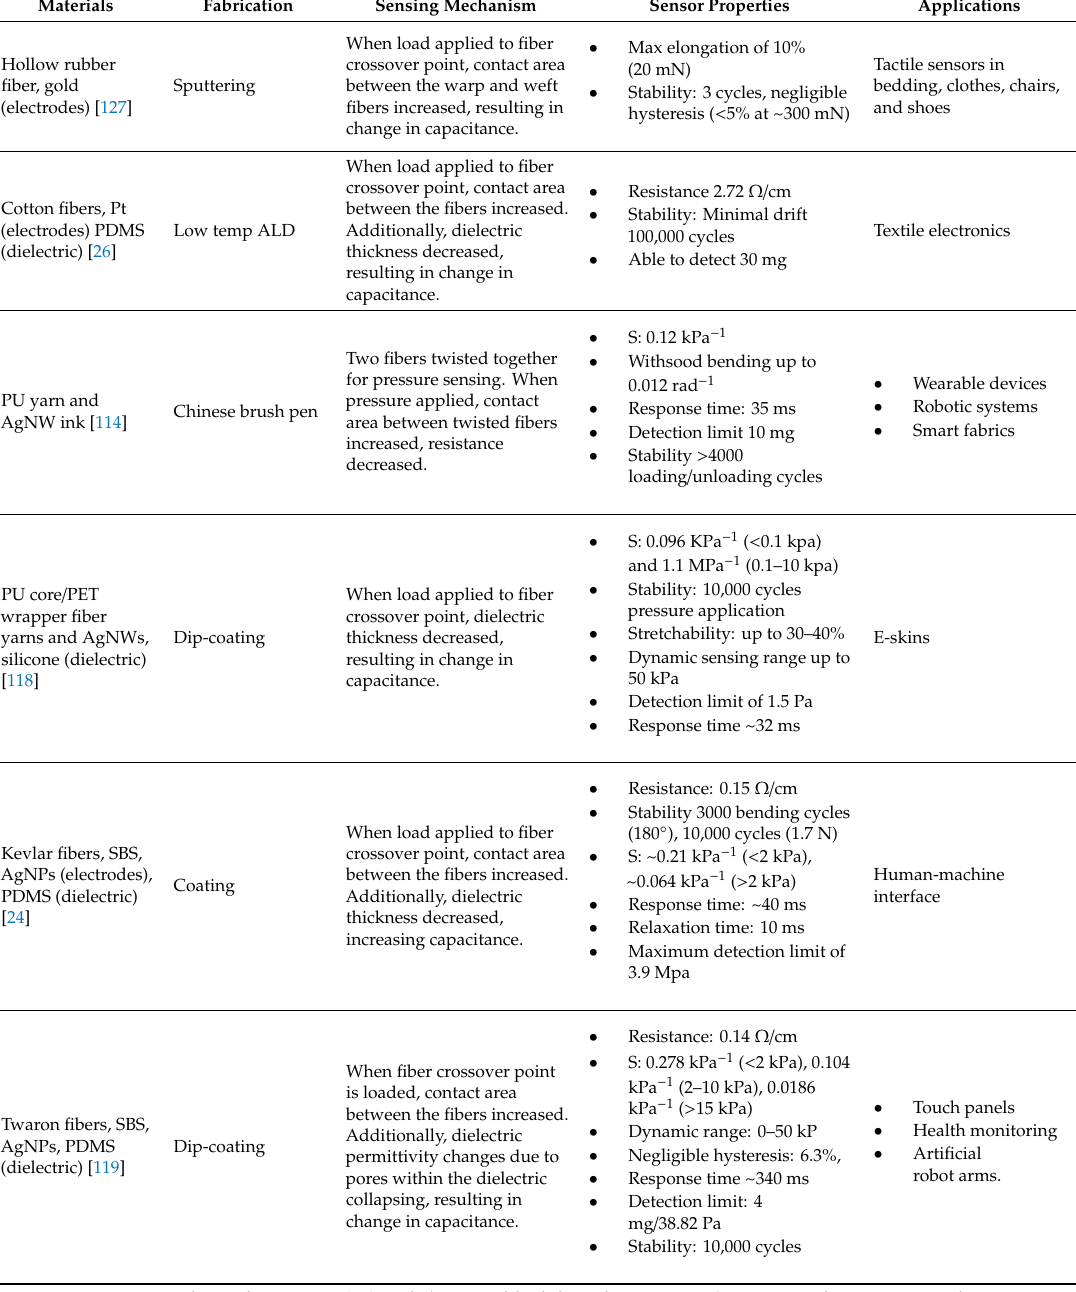
Table 7. Fiber-based pressure sensors coated with